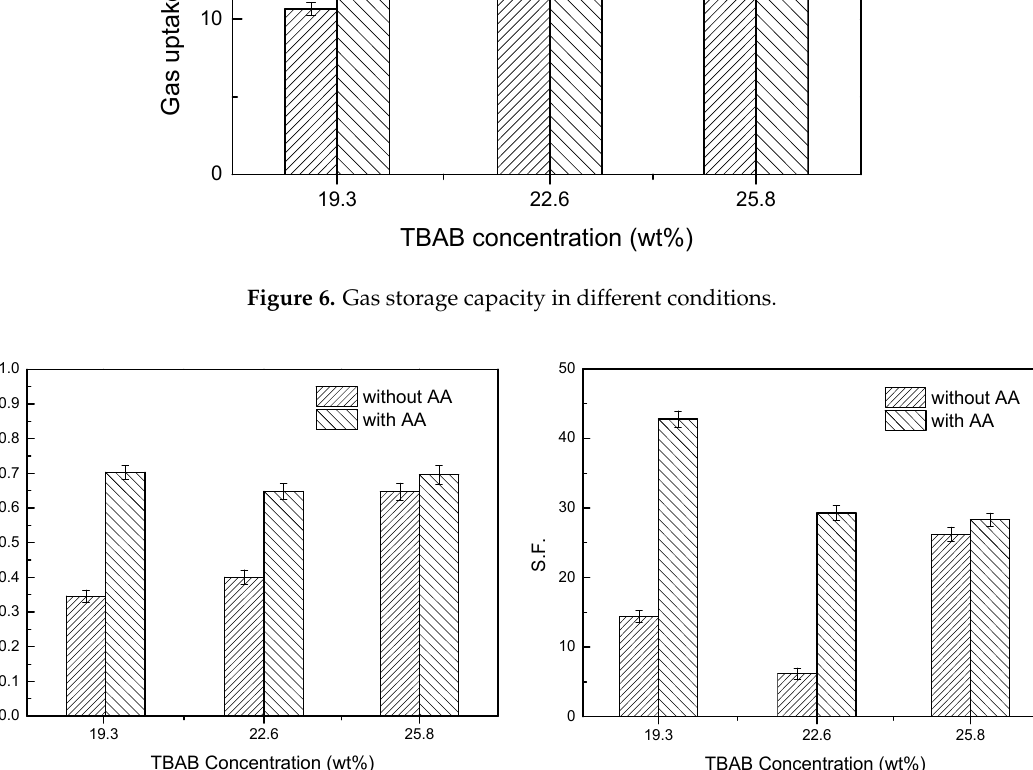
Table 3. Theoretical value of CO 2 storage in different conditions.